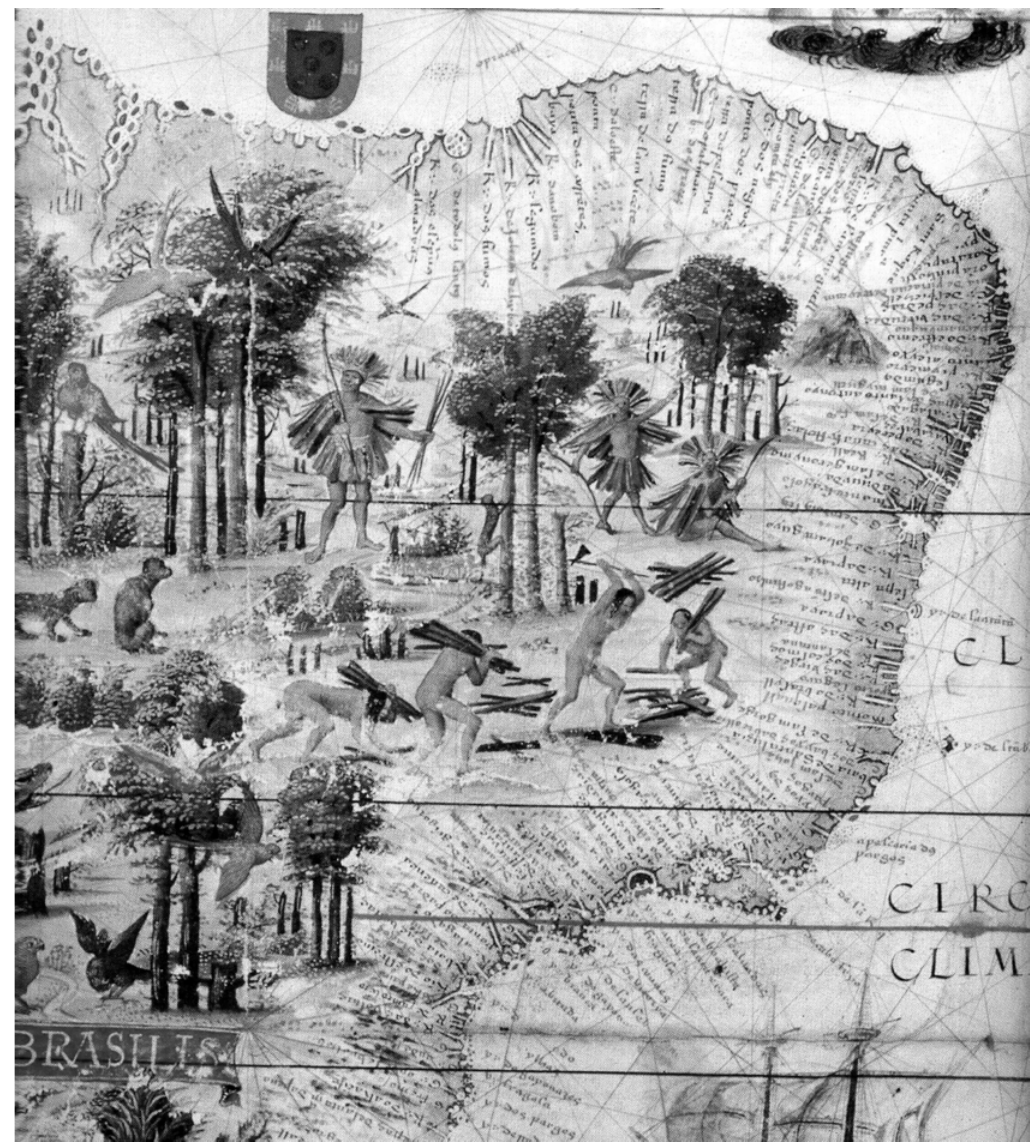
Fig. 1 – Detail of Carta do Brasil , made by Lopo Homem-Reinéis, 1519 (Couto